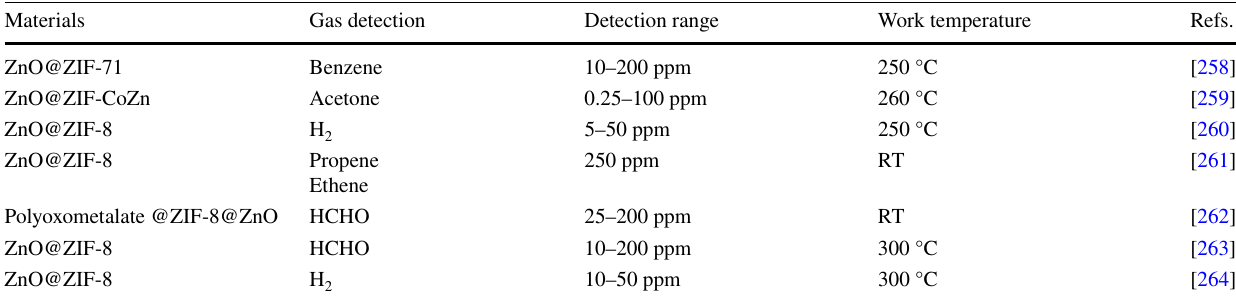
Table 5 Representative works based on molecular probing and sieving effect Materials Gas detection Detection range Work temperature